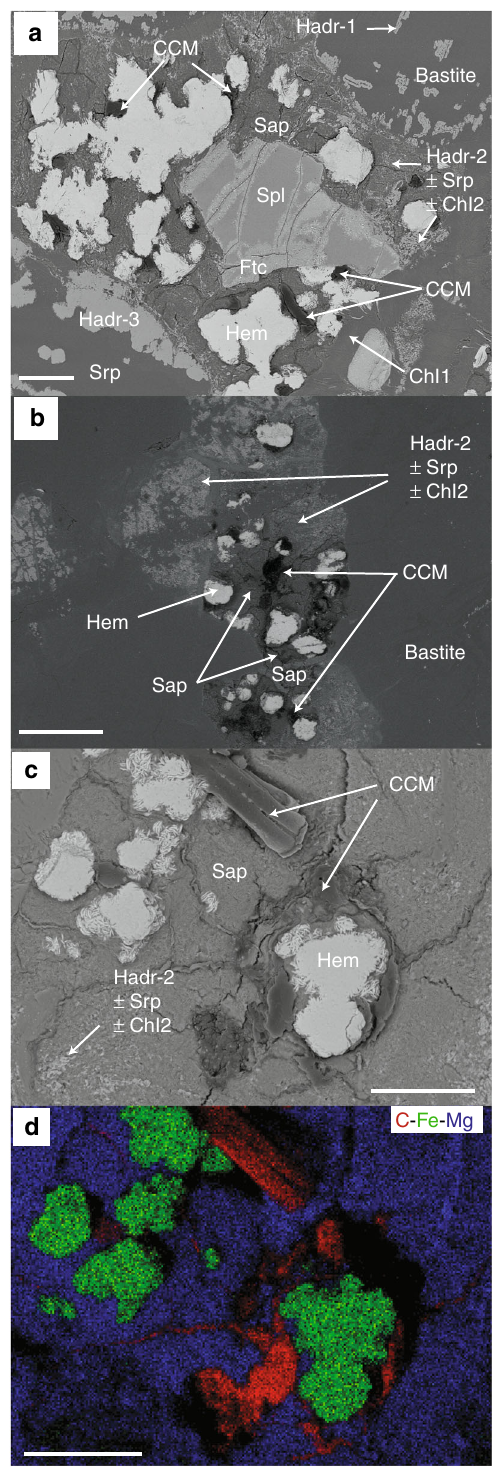
contains large hydroandradites (Hadr-3; Fig. 2a and Supplemen- tary Table 13) developed on the edges of serpentine veins (Supplementary Table 14), growing along serpentine fi bers. Their Cr 2 O 3 and TiO 2 contents are similar to Hadr-2 and Hadr-1, respectively (Supplementary Table 13). Multiple occurrences of condensed carbonaceous matter . Sig- ni fi cant amounts of CCM have been identi fi ed by scanning